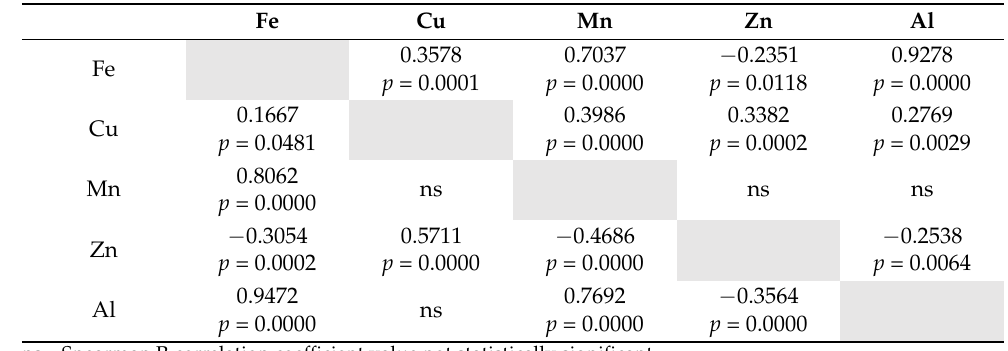
Table 5. R-Spearman correlation coefficients and p -value between micronutrients in the coat of Hucul horses overall, above diagonal for stable A, below for stable